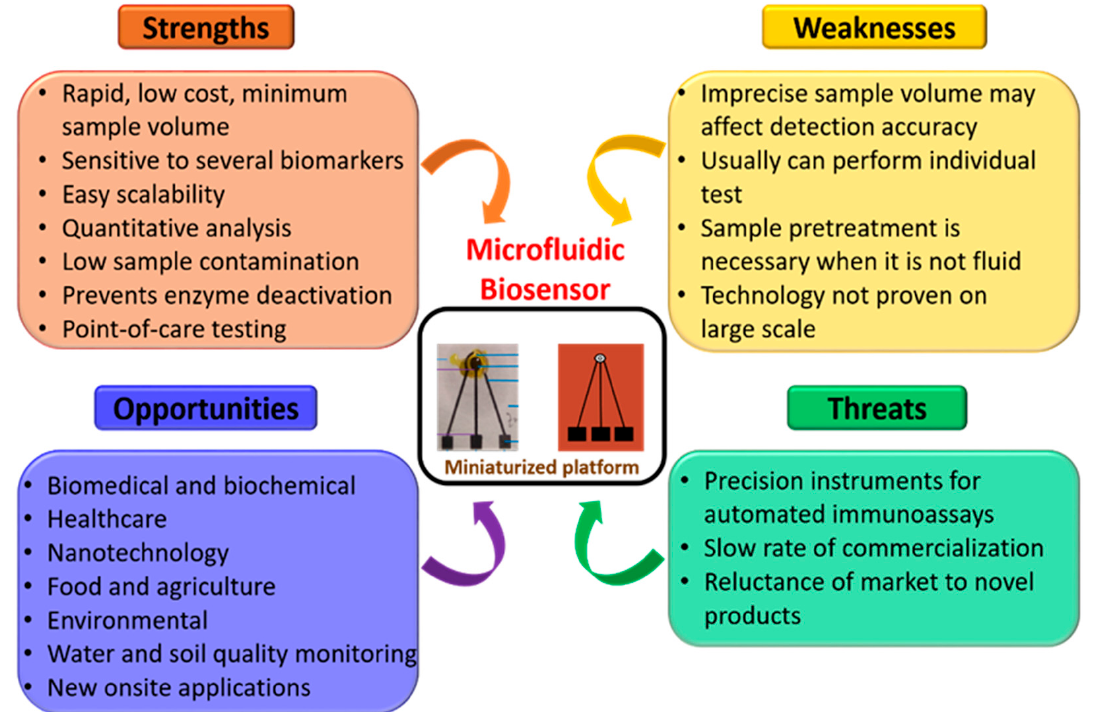
Figure 12. Detailed SWOT analysis of miniaturized biosensors.